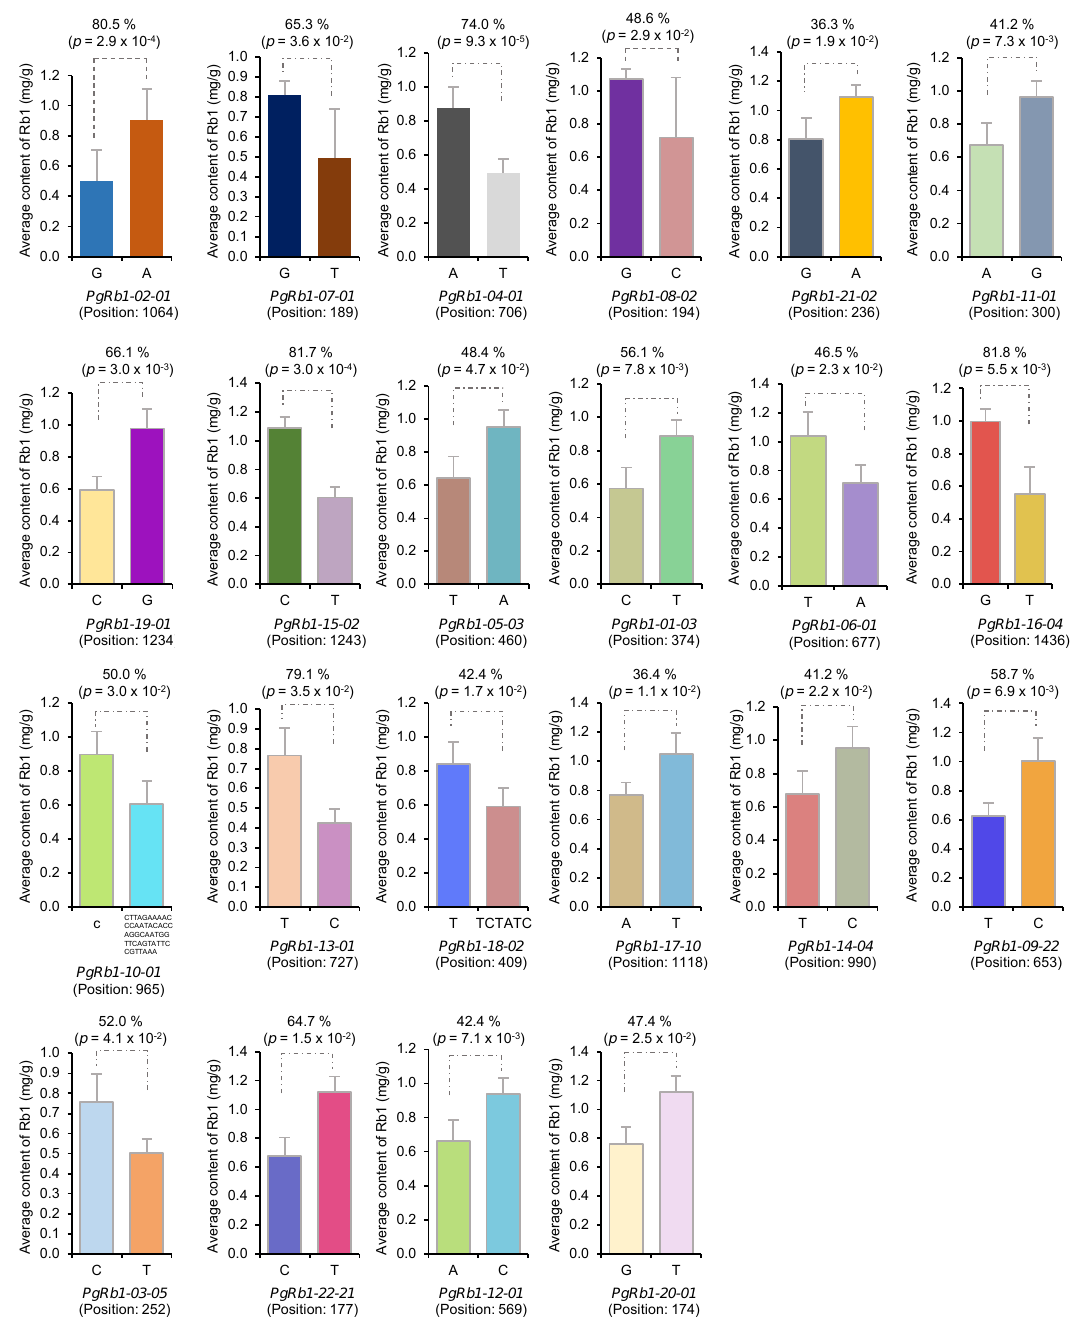
Figure 2. Biological impacts of the SNP/InDel mutations of the 22 DET-IIIs on Rb1 content in the four-year-old plant roots of 42 cultivars. Different colors indicate different SNP/InDel alleles. The mutation of each DET-III, e.g., PgRb1-02-01 , is shown above the DET-III name, such as Nucleotide “G” relative “A”. The position of the mutation is indicated in parenthesis below the DET-III. The impact of a mutation is shown above each figure in percentage of Rb1 content difference between the two homozygous cultivar groups in the lower-Rb1 content cultivar group. For detail see Table S2.